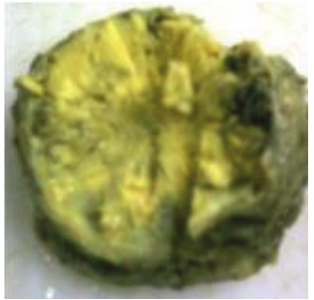
Figure 2: Gross specimen revealing well-circumscribed tumor with gray white to yellow gelatinous cut surface.